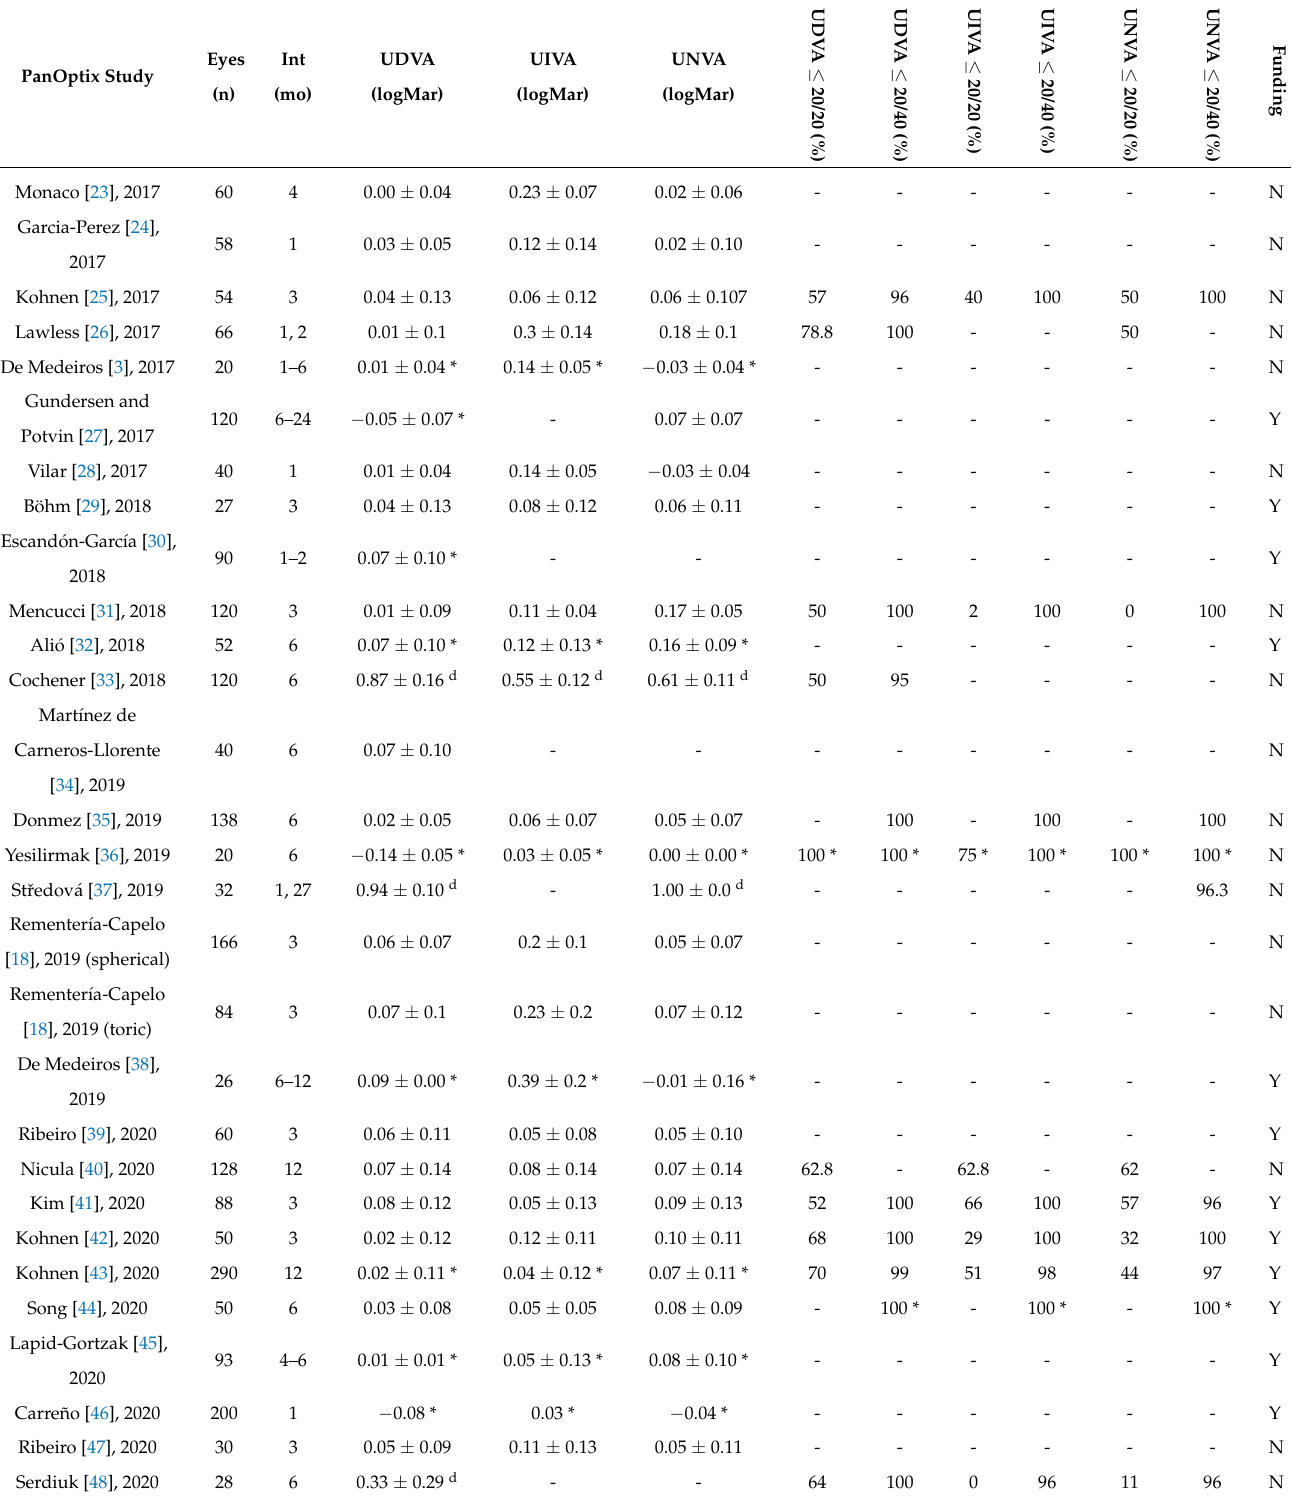
Table A2. Comparison of PanOptix IOL Visual Outcomes in Published